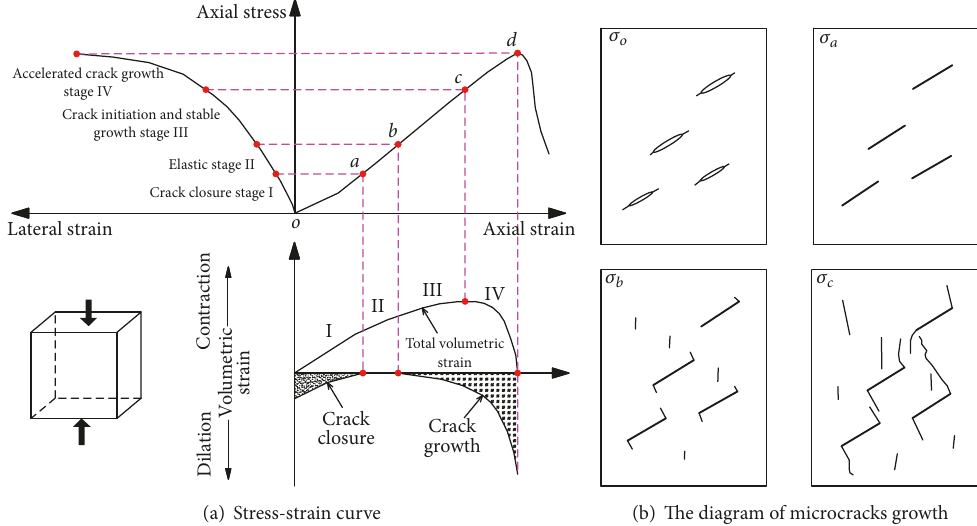
Figure 4: Typical stress-strain curve and microcracks growth of concrete (from the literature [13]).